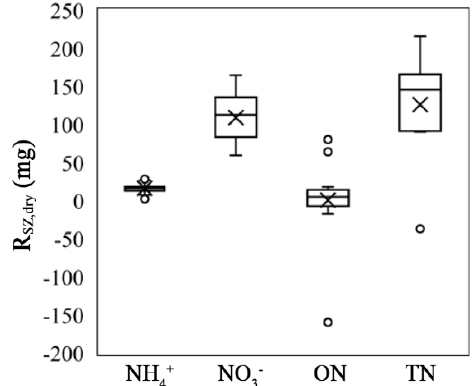
Figure 10. Contribution of SZ during dry periods to nitrogen species removal. In each box, five “-” represent the upper limit value, upper quartile value, median value, lower quartile value, and lower limit value of the data, respectively. “x” represents the mean value of the data, and “◦” represents the outlier value of the data.